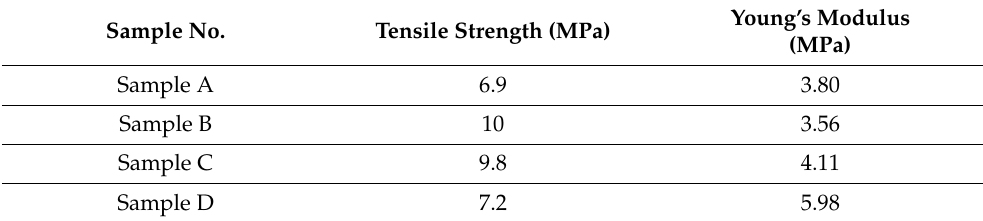
Figure 17. Stress–strain graphs of insulation composites. Table 7. Mechanical properties of insulation composites. Sample No.